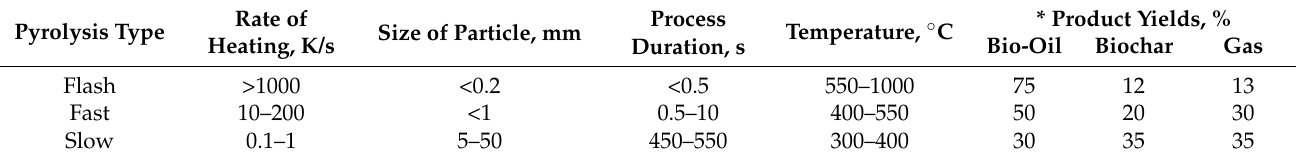
Table 2. The technological parameters and product yield typically linked to pyrolysis